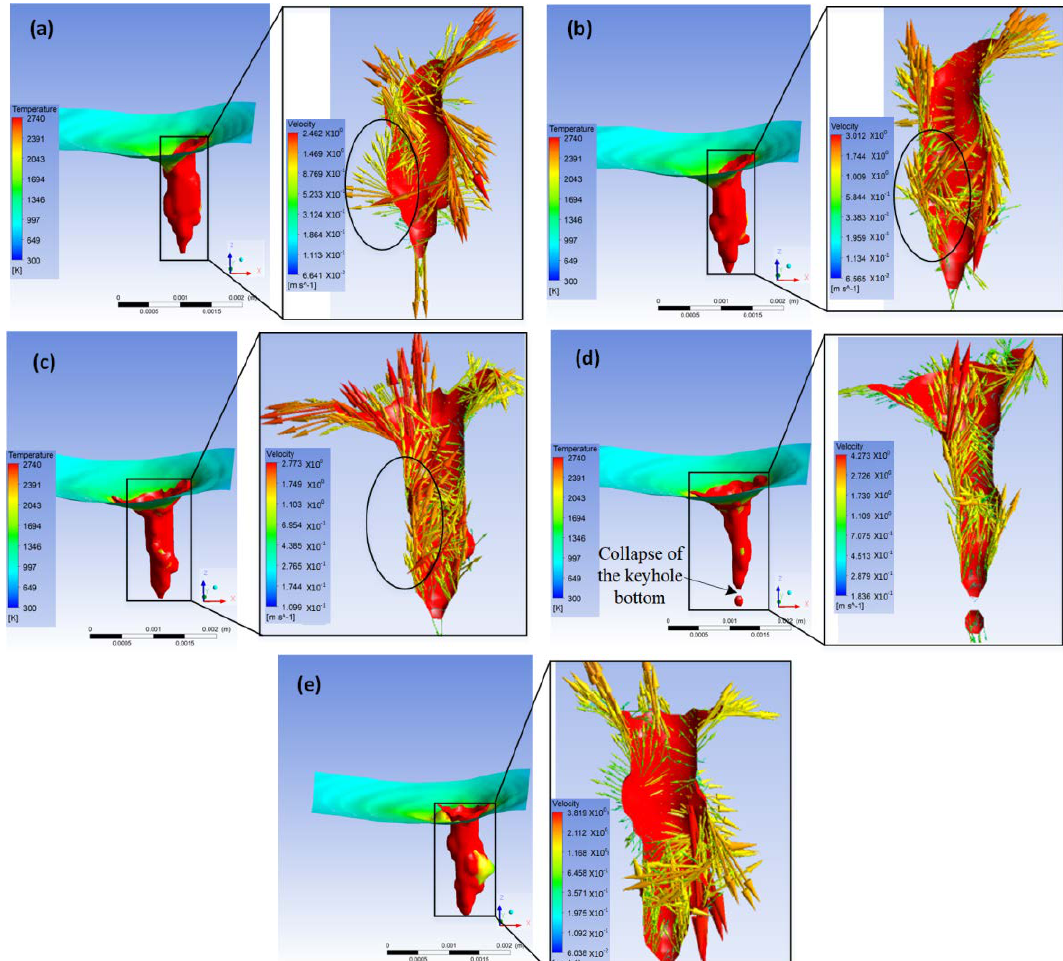
Figure 5. The dynamic fluctuation of keyhole wall and the melt flow on keyhole wall with preheating temperature of 400 K: ( a ) t = 26.4 ms, ( b ) t = 26.5 ms, ( c ) t = 26.7 ms, ( d ) t = 26.8 ms, ( e ) t = 29 ms.